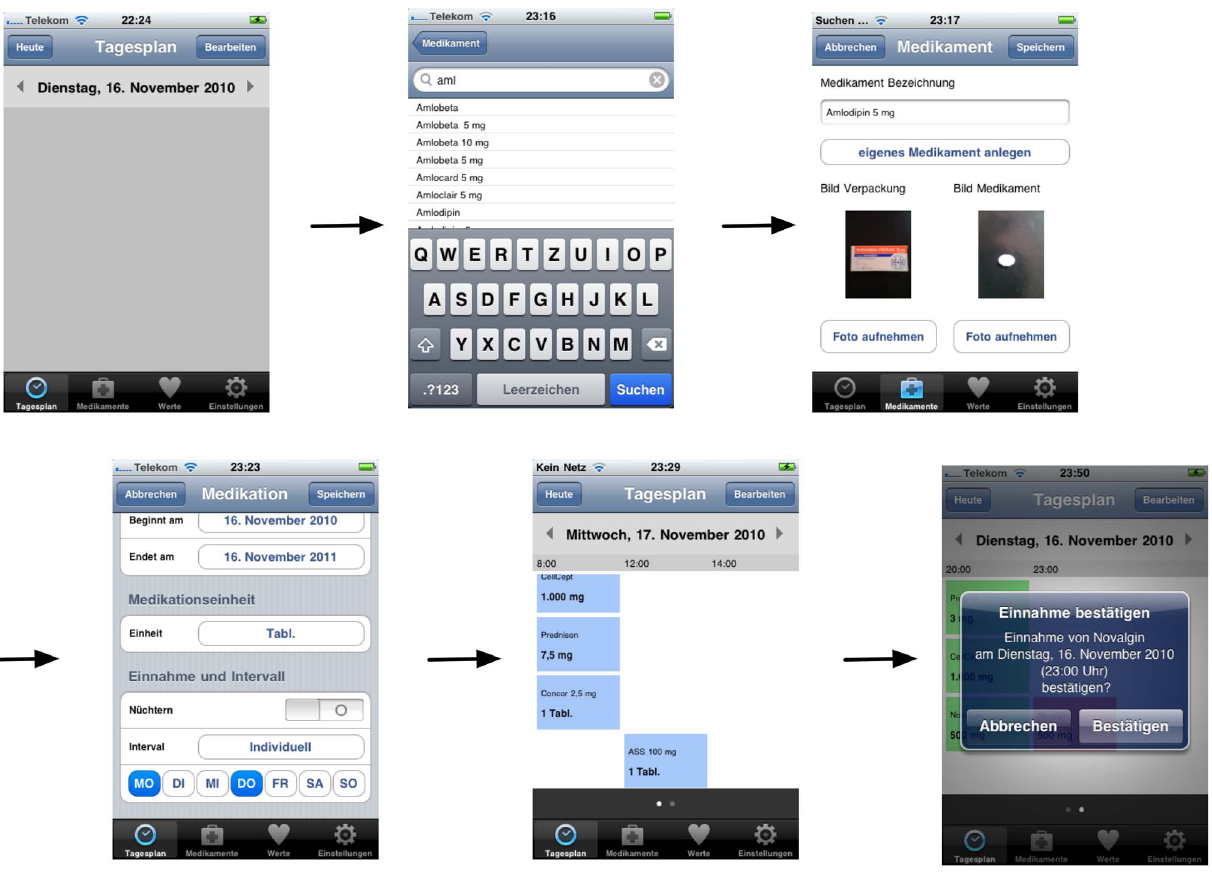
Figure 1. Generating a medication plan on the smartphone (exemplary screenshots).